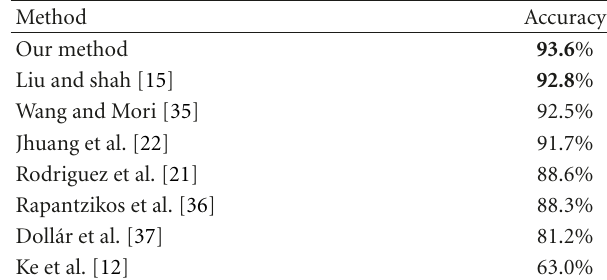
Table 2: Comparison with other methods done using KTH